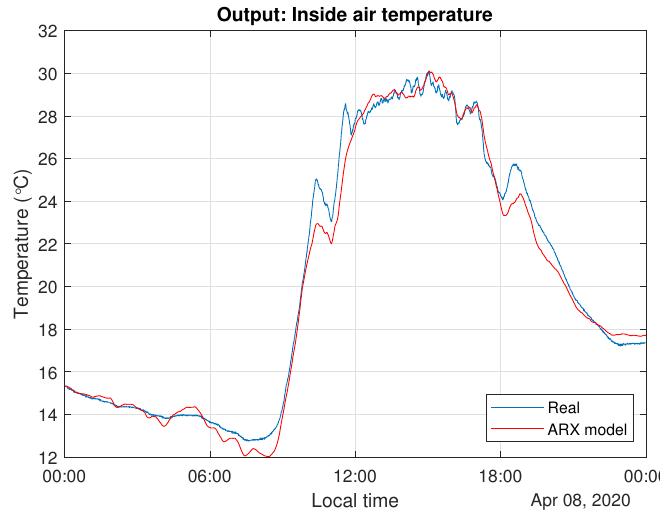
Figure 8. Results for ARX model identification compared against real inside air